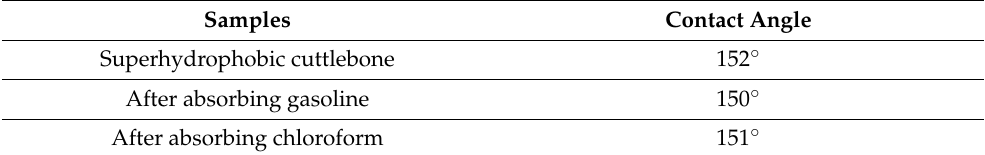
Table 1. Contact angle of superhydrophobic cuttlebone before and after oil absorption.